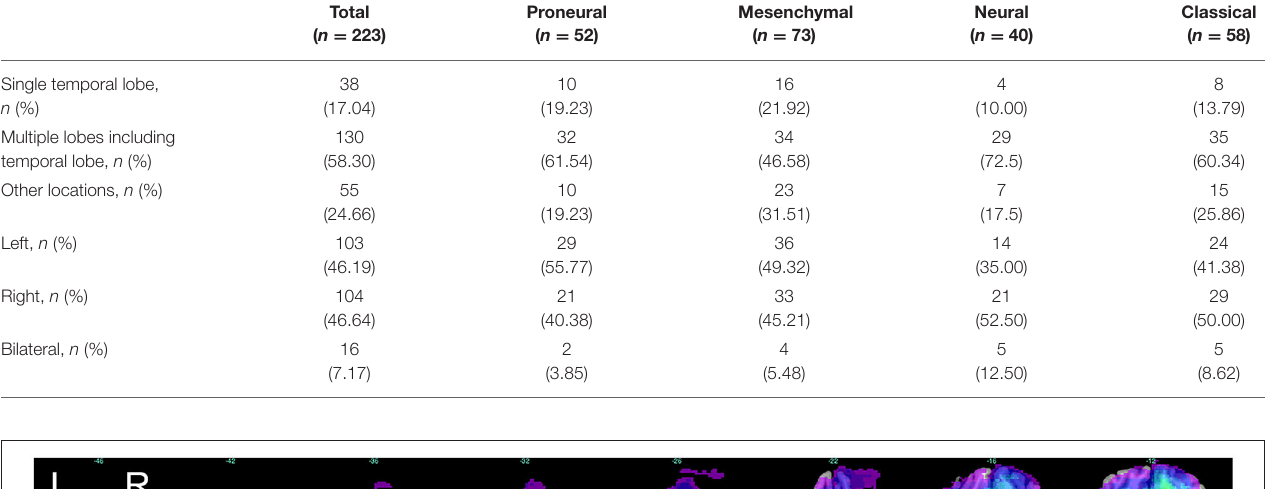
TABLE 1 | The distribution of different subtypes based on tumor locations.